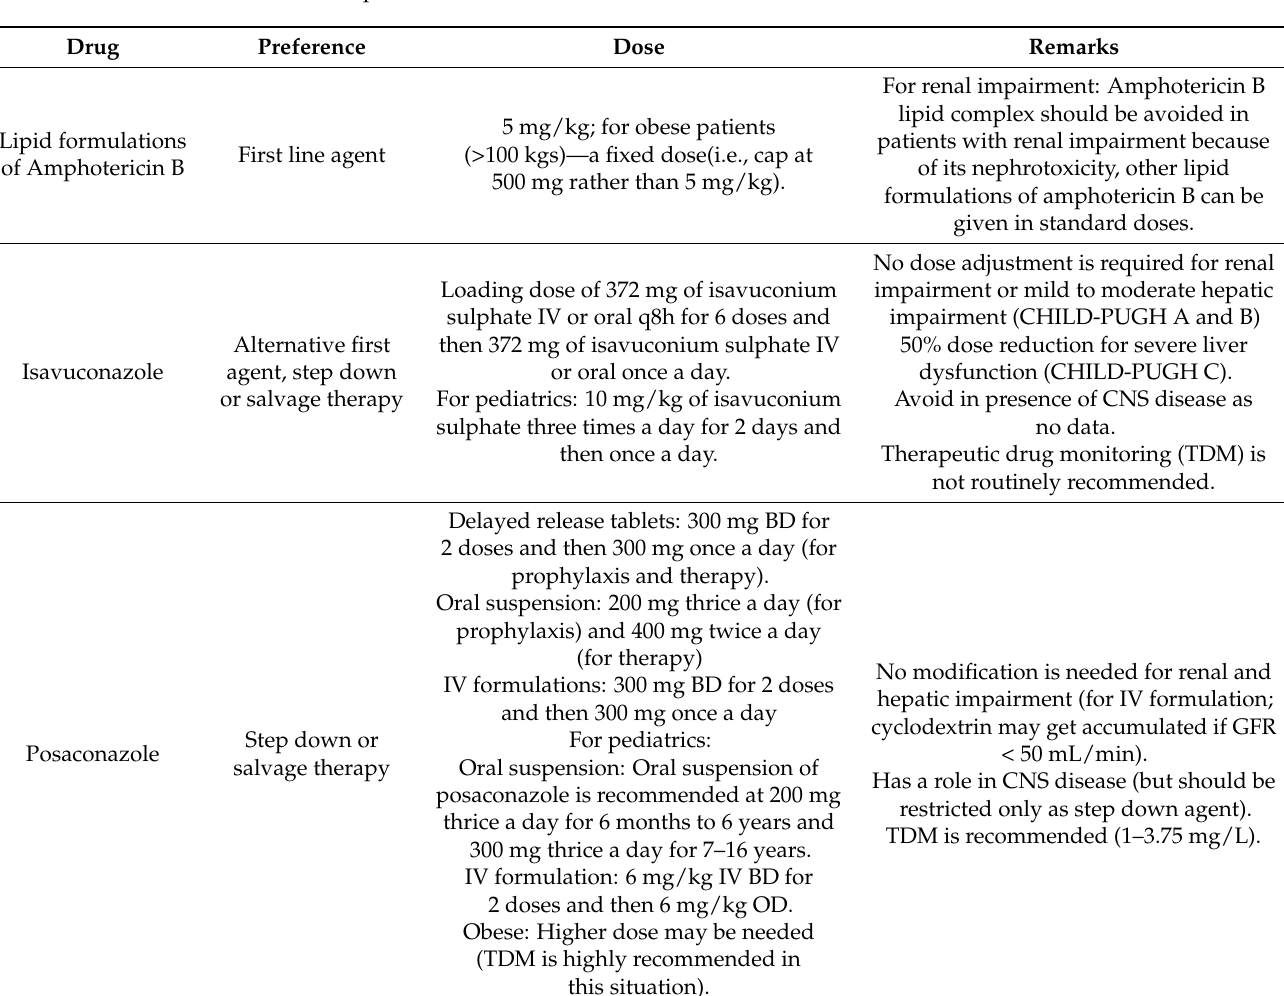
Table 2. Dosing recommendations of various anti-fungal drugs used to treat Mucormycosis in routine and special